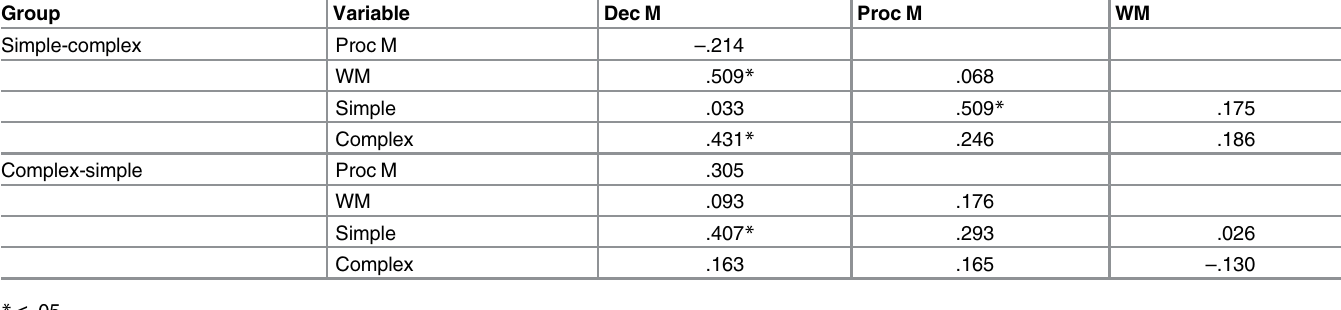
Table 6. Pearson correlations between the memory measures and learning of the simple and complex grammatical patterns by the simple-com- plex and complex-simple training order groups. Group Variable Dec M Proc M WM Simple-complex Proc M – .214